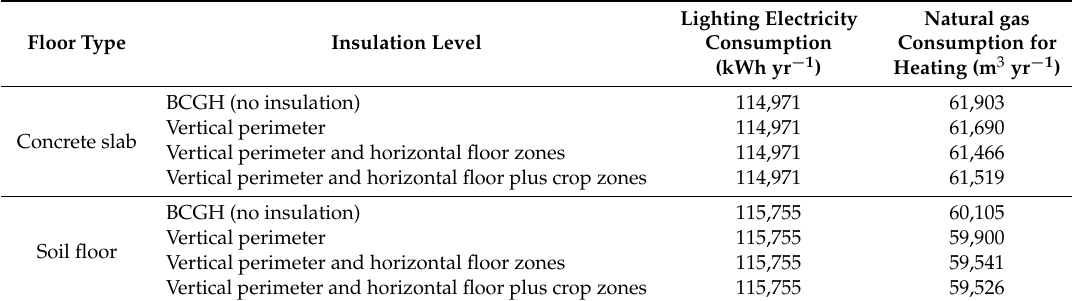
Table 4. Energy consumption for the greenhouse models.